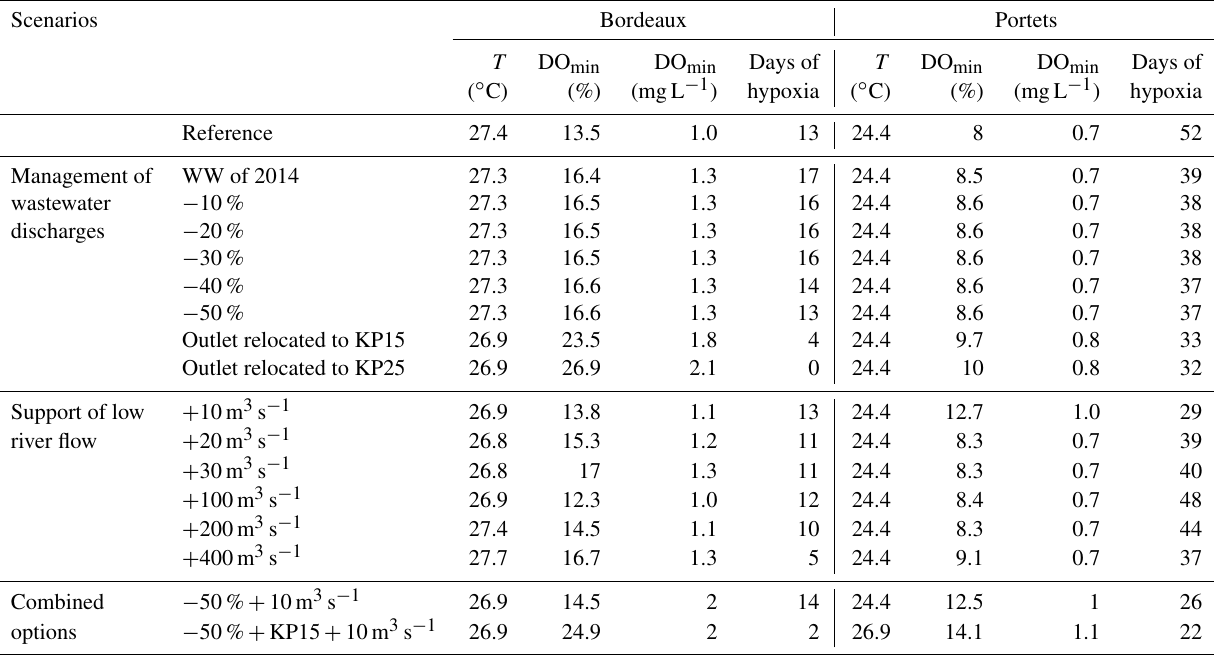
Table 2. Minimum simulated DO (in % saturation and in mgL − 1 ), the corresponding temperature, and the number of hypoxia days in Bordeaux and Portets for each scenario. (WW: